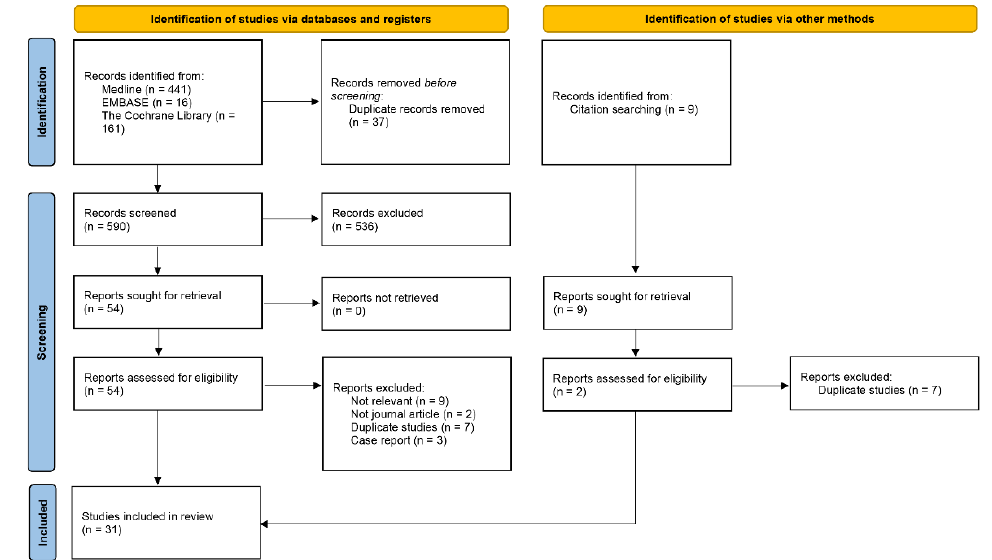
Figure 1. Study identification and selection.